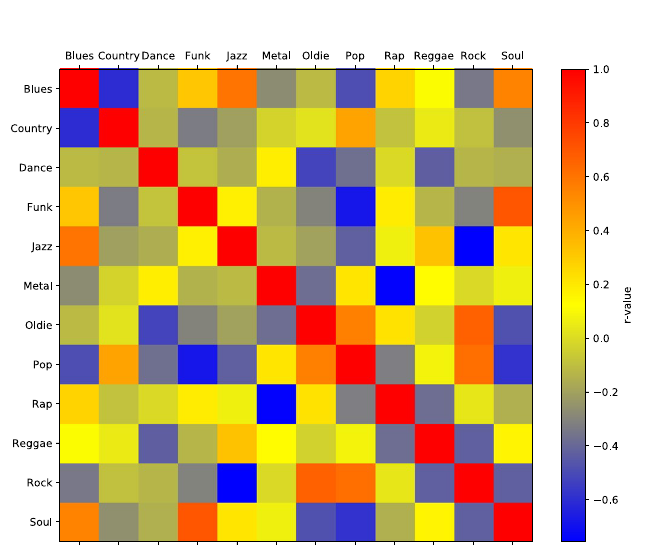
Figure 4. Spearman correlations between Joint importance profiles for different Musical